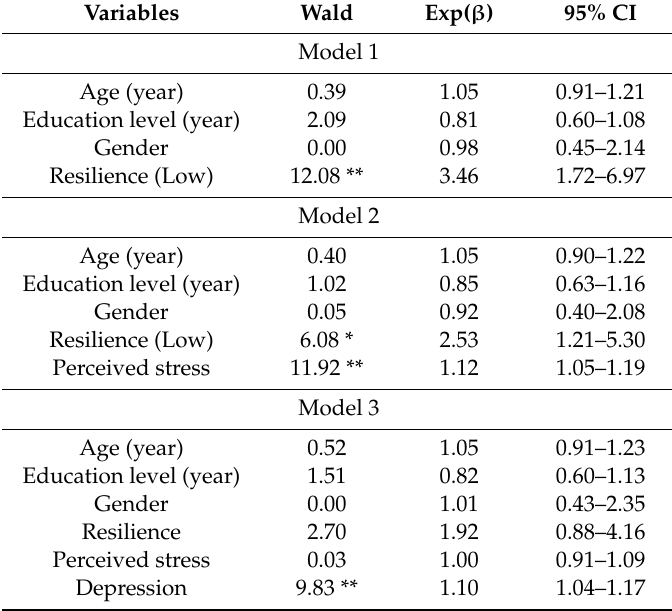
Table 3. Hierarchical logistic regression model of Internet gaming disorder for resilience, perceived stress, and depression controlling for gender, age, and education